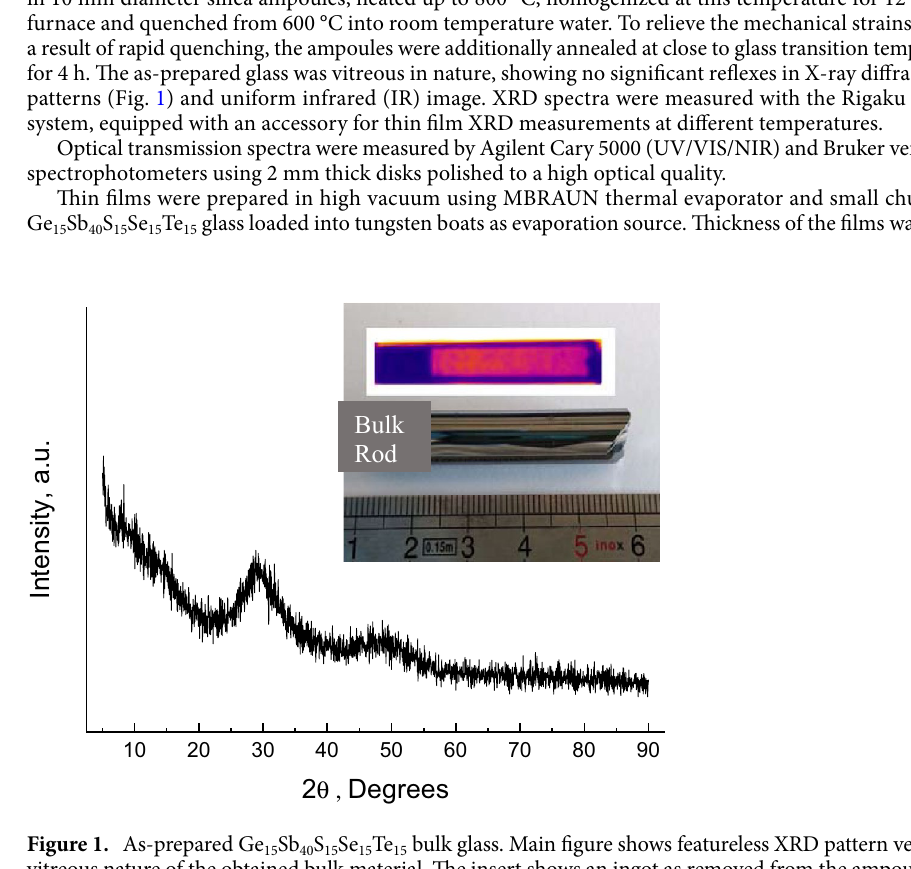
Figure 1. As-prepared Ge 15 Sb 40 S 15 Se 15 Te 15 bulk glass. Main figure shows featureless XRD pattern verifying vitreous nature of the obtained bulk material. The insert shows an ingot as removed from the ampoule and its IR image, testifying good homogeneity of the prepared bulk